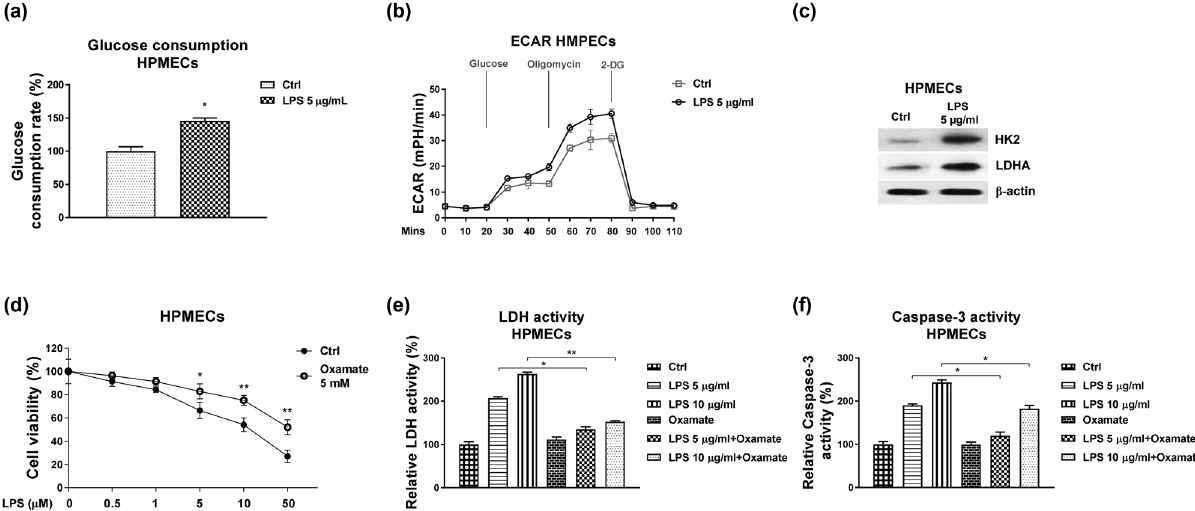
Figure 4: Glycolysis rate of HPMECs is elevated by LPS stimulation. ( a ) HPMECs were treated with control or LPS at 5 µg/mL. The glucose consumption, ( b ) ECAR and ( c ) glycolysis enzymes were examined. ( d ) HPMECs were treated with control or Oxamate at 5 mM, followed by treatments with LPS at the indicated concentrations. Cell viability was examined by MTT assay. ( e and f ) HPMECs were treated with LPS alone or with Oxamate at the indicated concentrations. The LDH activity and Caspase - 3 activity were examined. *, p < 0.05; **, p < 0.01.